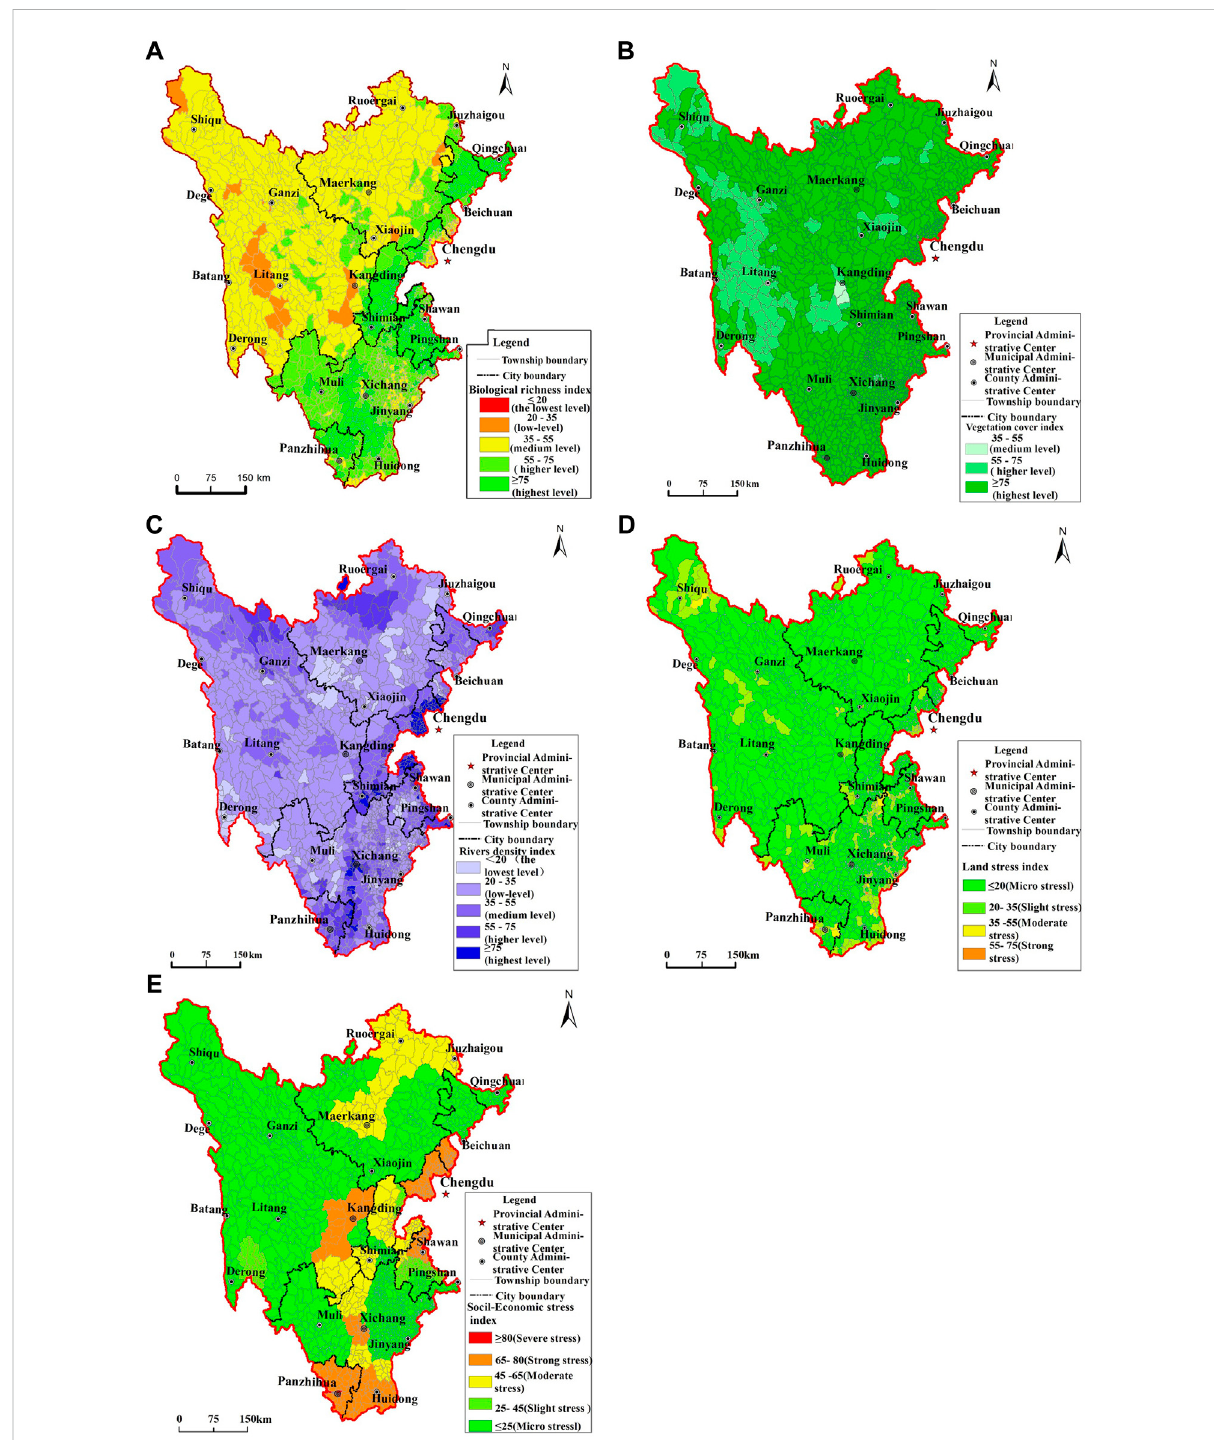
FIGURE 6 Assessmentindicatorinyear2009. (A) Biologicalrichnessindex, (B) Waternetworkdensityindex, (C) Vegetationcoverageindex, (D) Landstress index, (E) Social-economic stress